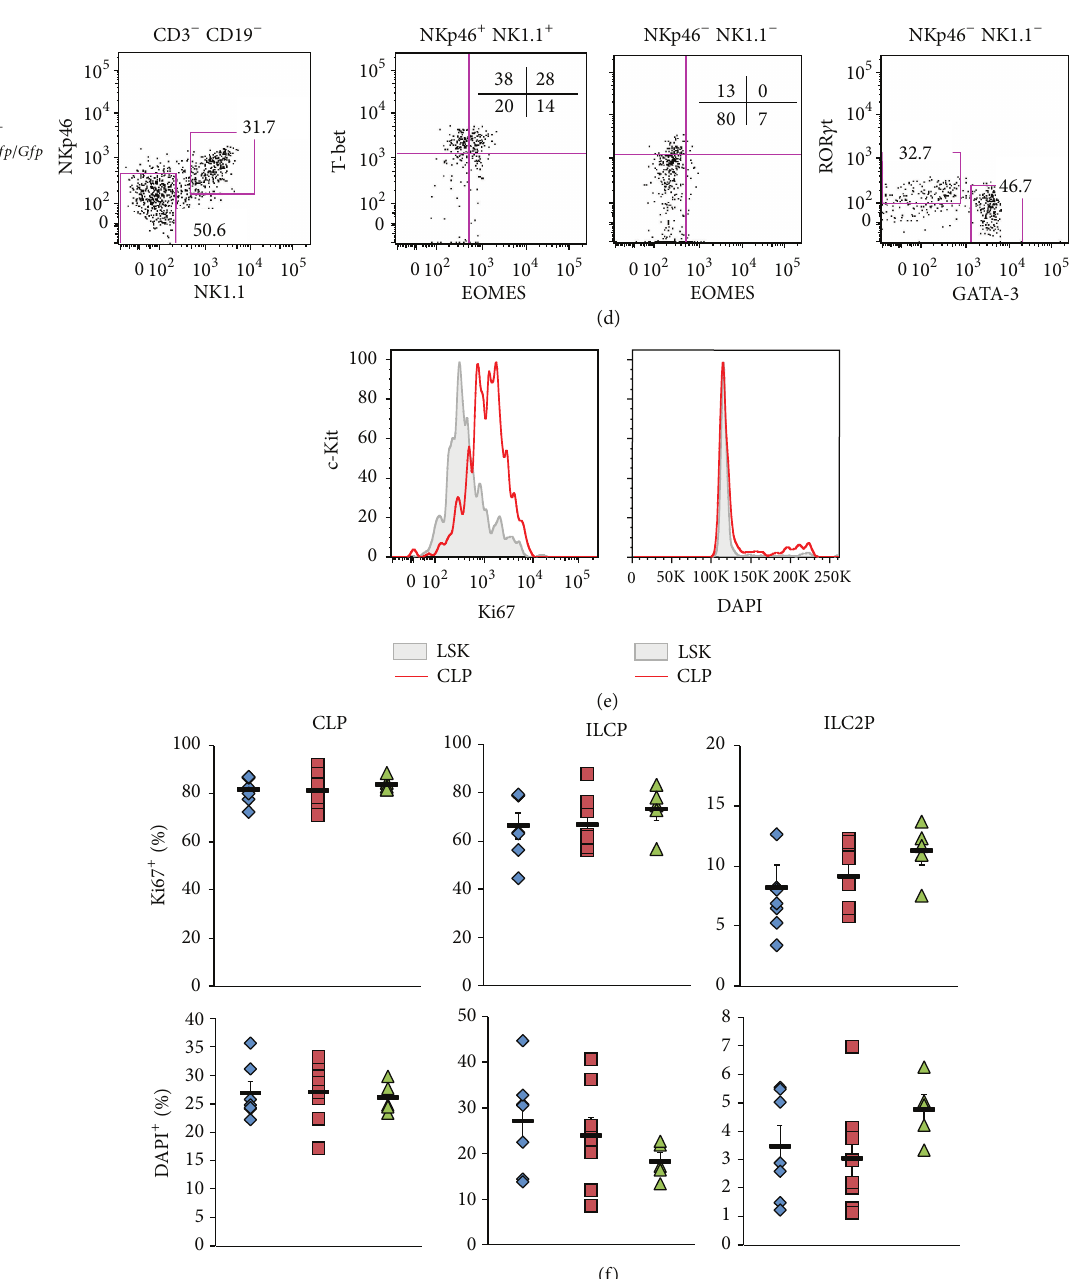
Figure 2: CXCR6-deficient precursors are retained in the bone marrow. (a) Percentages in Lin − (upper panels) and absolute numbers (lower panels) of BM CLP, ILCP, and ILC2P as defined in Figure 1(a) from Rag2 − / − Cxcr6 + / + (wt, blue losange), Cxcr6 Gfp/+ (HZ, red square), or Cxcr6 Gfp/Gfp (KO, green triangle) adult mice. (b) Histograms depicting levels of CXCR6-GFP in ILCP (left panel) or ILC2P (right panel) from Rag2 − / − Cxcr6 + / + (filled gray), Cxcr6 Gfp/+ (red line), or Cxcr6 Gfp/Gfp (green line) bone marrows. (c) Percentages of CXCR6 + cells (upper panels) and absolute numbers of (lower panels) BM ILCP (left panels) and ILC2P (right panels) in Rag2 − / − Cxcr6 Gfp/+ (HZ, red square) or Cxcr6 Gfp/Gfp (KO, green triangle) adult mice. (d) Cell culture of BM ILCP from Rag2 − / − Cxcr6 Gfp/+ (upper panels) or Cxcr6 Gfp/Gfp (lower panels) adult mice. Each population is sorted and cultured at 20 cells per well on OP9-DL4 stromal cells with IL-7, c-KitL, and Flt3-L for 7 days and analyzed by flow cytometry. Indicated obtained progenies were analyzed for T-bet, EOMES, ROR 𝛾 t, and GATA-3 expression. (e) Histograms of BM LSK cells (filled gray, selected as Lin − IL-7R 𝛼 − c-Kit hi Sca-1 + ) and CLP (red line) for Ki67 expression and DAPI levels. (f) Percentages of Ki67 + cells (upper panels) and DAPI + cells (lower panels) among BM CLP, ILCP, and ILC2P in Rag2 − / − Cxcr6 +/+ (wt, blue losange), Cxcr6 Gfp/+ (HZ, red square), or Cxcr6 Gfp/Gfp (KO, green triangle) adult mice. Data are representative of at least 3 experiments ((b), (e): 𝑛 > 5 ), or are from one experiment ((d), at least 4 wells of each conditions), or are from 3 pooled experiments ((a), (c), (f), wt: 𝑛 = 8 , HZ: 𝑛 = 8 , KO: 𝑛 = 5 ). In ((a), (c), (f)), each dot represents a single mouse. Statistical data are displayed with mean and SEM (Student’s unpaired bilateral test, ∗ 𝑝 < 0.05 ; ∗∗ 𝑝 < 0.01 ; ∗∗∗ 𝑝 < 0.005